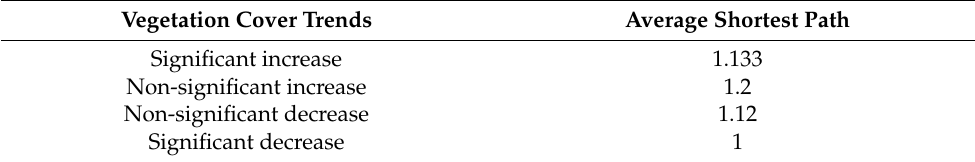
Table 7. Average shortest paths for areas with different vegetation cover trends.